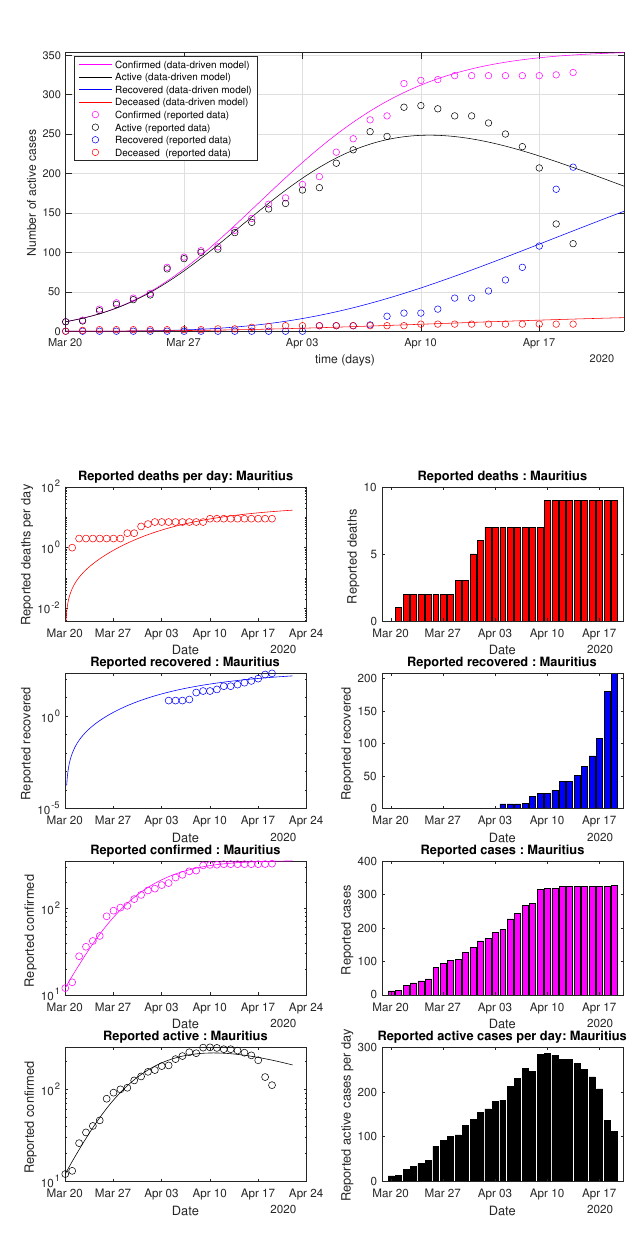
Figure 74. Mauritius: data vs.